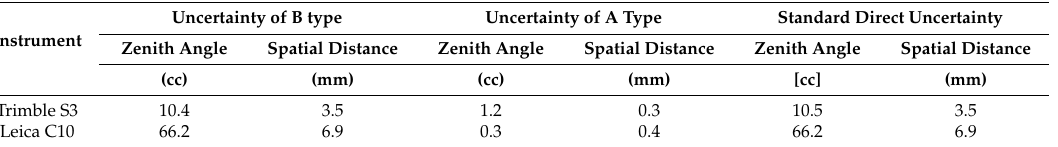
Table 3. The values of the direct uncertainty.